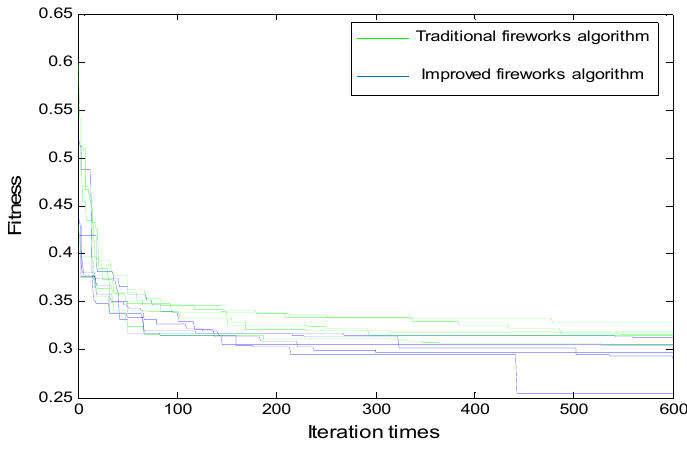
Figure 8. The curve of fitness.